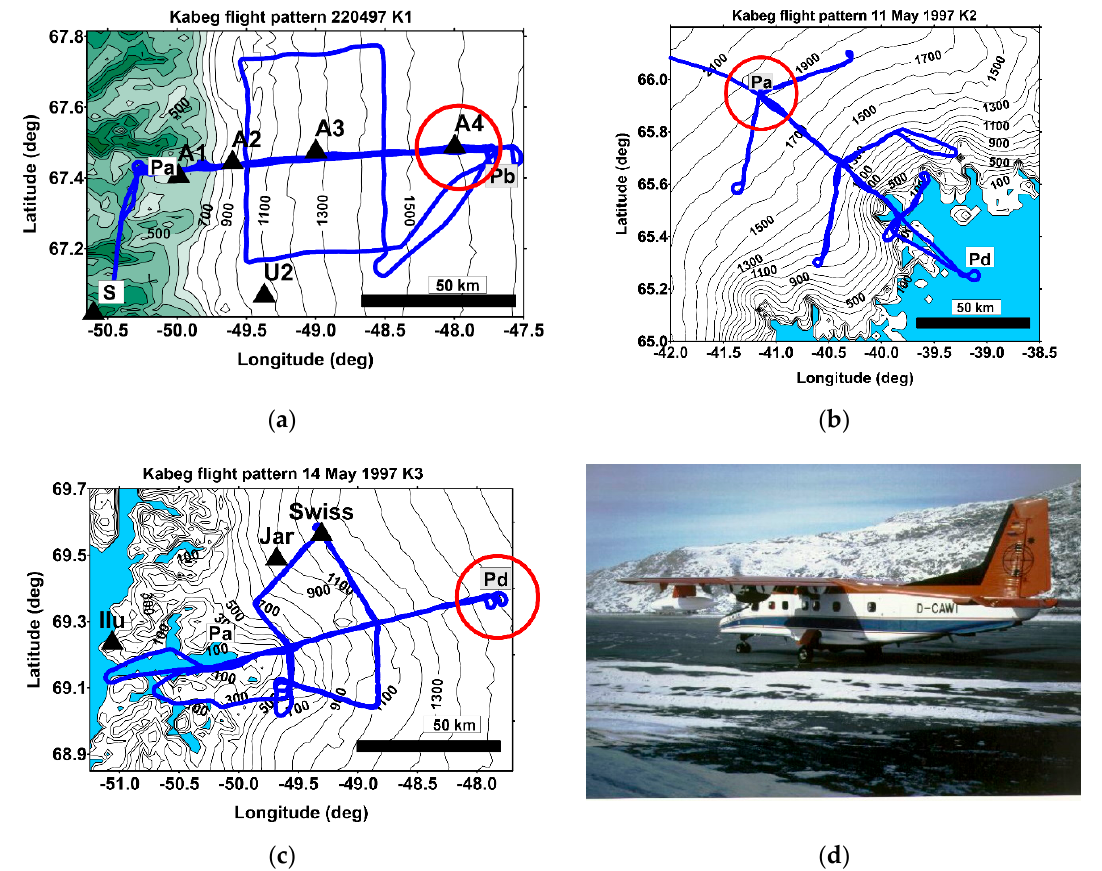
Figure 3. Detailed maps of the areas of the KABEG experiment (see Fig.2) with superimposed flight tracks with reference points. ( a ) area K1, ( b ) area K2, ( c ) area K3. The red circles mark the positions for comparisons of vertical profiles (A4 for K1, Pa for K2, and Pd for K3). The black triangles mark positions with meteorological measurements. A picture of the aircraft POLAR2 is shown in panel ( d ). Table 1. KABEG flights and positions used for comparison with CCLM for April and May 1997.